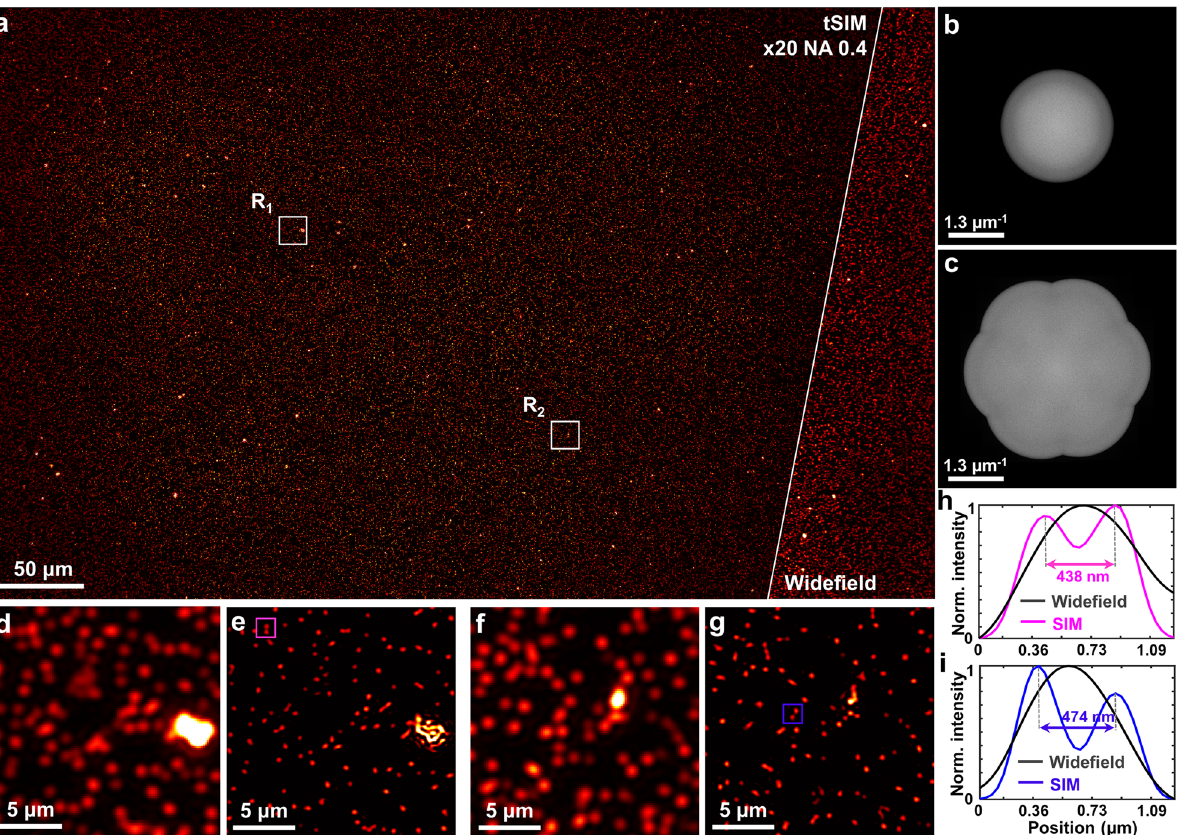
widefield images of white box in R 1 and R 2 regions, respectively; ( e , g ) closeup of the tSIM reconstruction in R